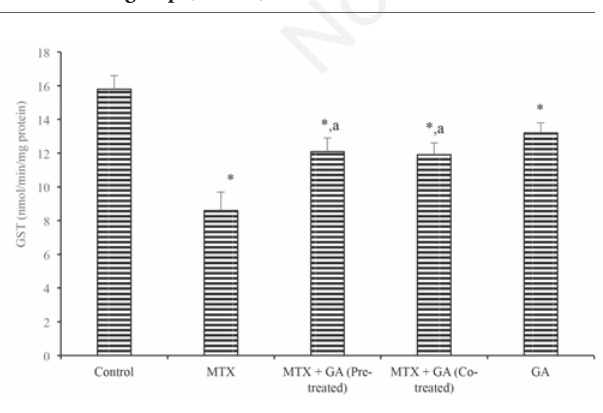
Figure 2. Ameliorative effect of gallic acid pre-treatment and co- treatment on methotrexate-induced reduction in hepatic glu- tathione S-transferase (GST) activity in rats. Data are expressed as mean ± S.D for six rats in each group. *Significantly different from the control (P<0.05); a significantly different from the methotrexate group (P<0.05).